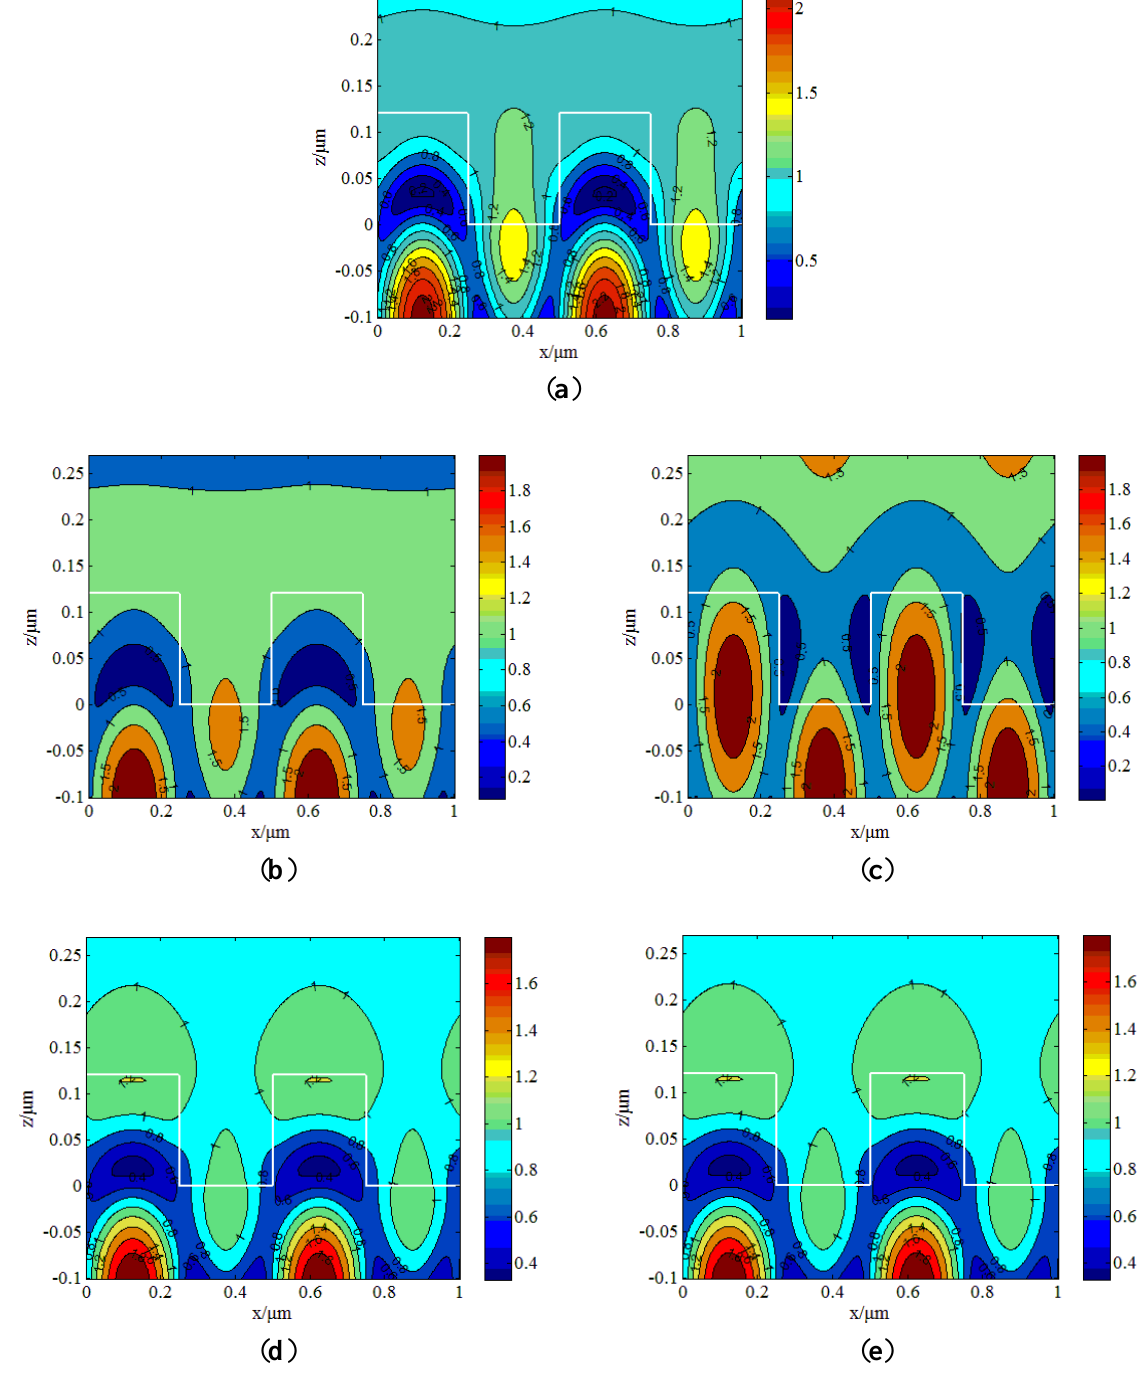
Figure 3. Electric field distribution of TM mode at different wavelengths. ( a ) Electric field distribution at the wavelength of 766 nm with TM mode incident into the GMRF. ( b ) Wavelength at 763 nm. ( c ) Wavelength at 769 nm. ( d ) Wavelength at 760 nm. ( e ) Wavelength at 772